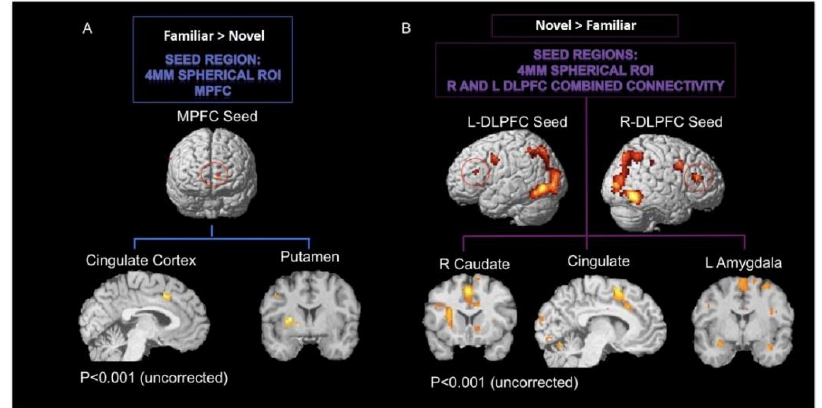
Figure 7. Regions demonstrating significant connectivity for the ( A ) familiar CS > novel CS and ( B ) novel CS > familiar CS contrasts.